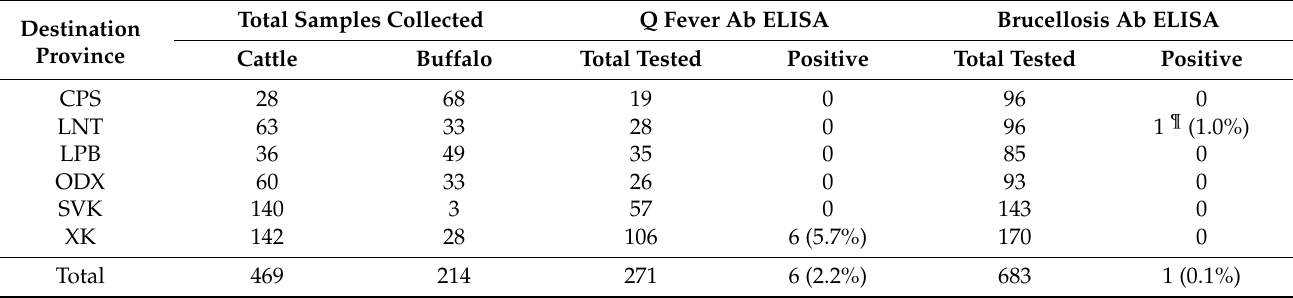
Table 2. Summary of the serum samples and test results in six